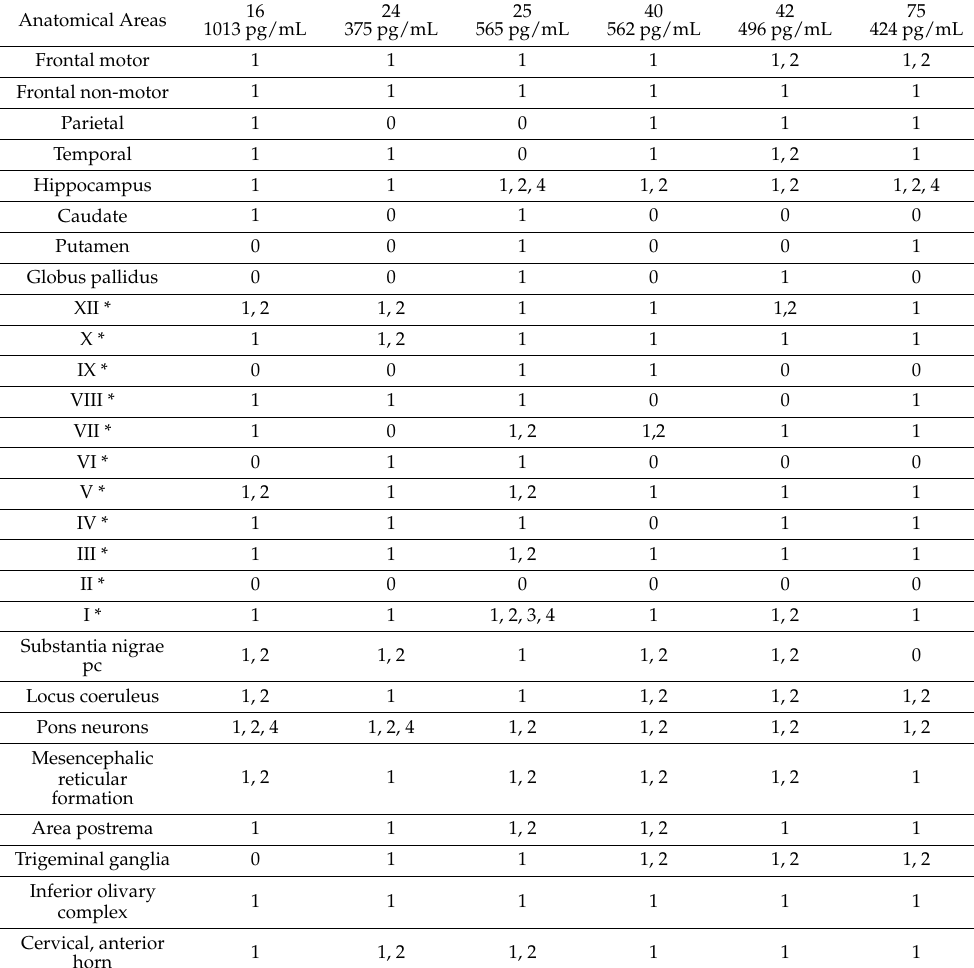
Table 3. Neuropathology findings in the six MMC males with cisternal CSF TDP-43 data and TDP-43 neuropathology. Numbers represent: (1) complete loss of nuclear TDP-43 expression; (2) dash-like immunoreactive (IR) particles in the vicinity of neuronal nuclei; (3) skein-like tangles in